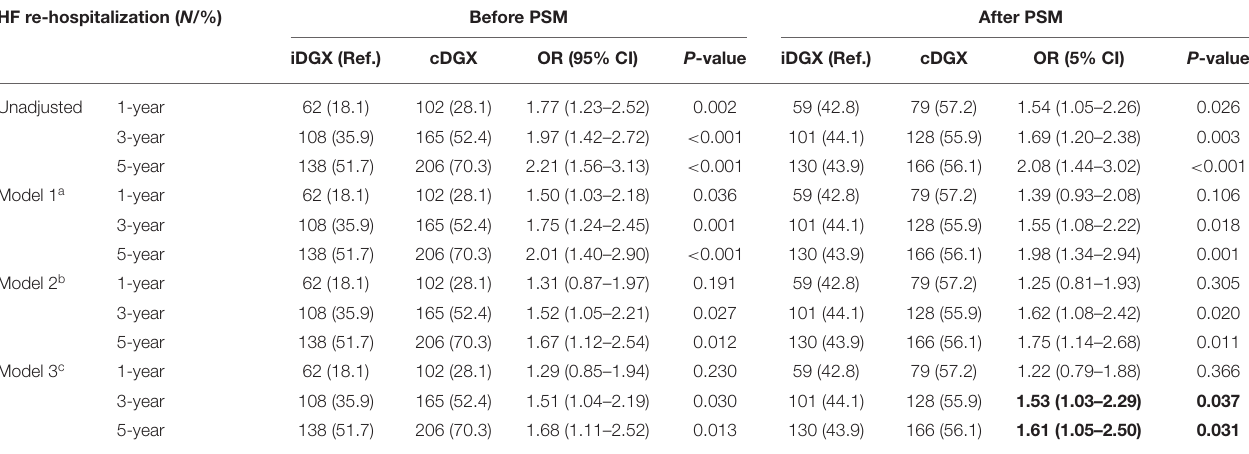
TABLE 4 | Association of DGX application methods with HF re-hospitalization in RHD